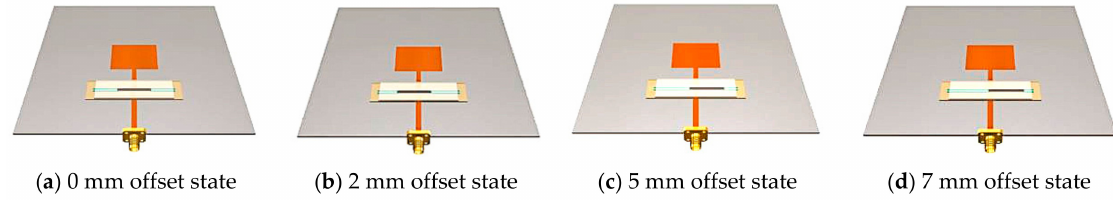
Figure 23. States of the Galinstan slug. ( a ) The 0 mm offset state. ( b – d ) The X -mm-offset state [17].